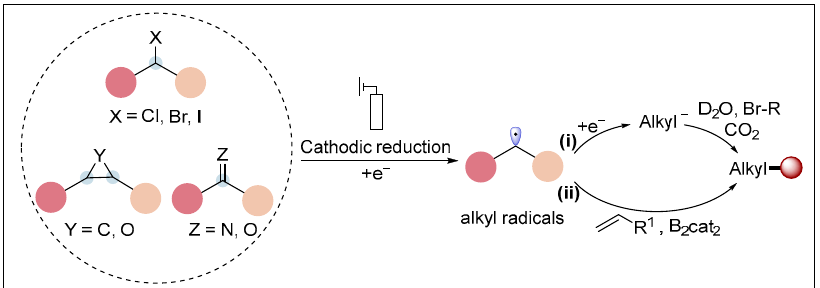
Figure 2. General mechanism of electroreductive transformations via alkyl radicals.